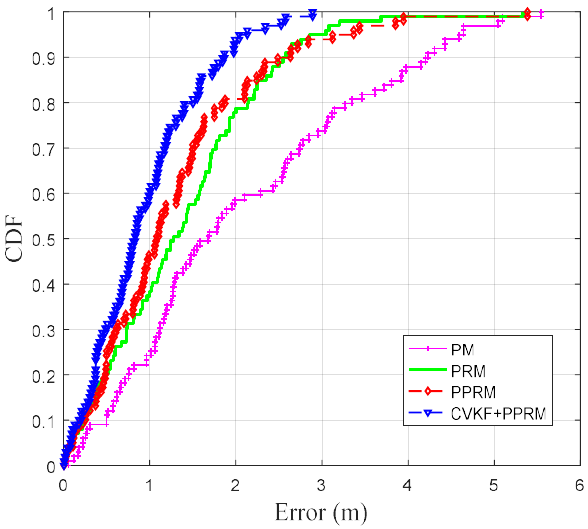
Figure 8. CDFs of real-time distance estimation errors under four models.